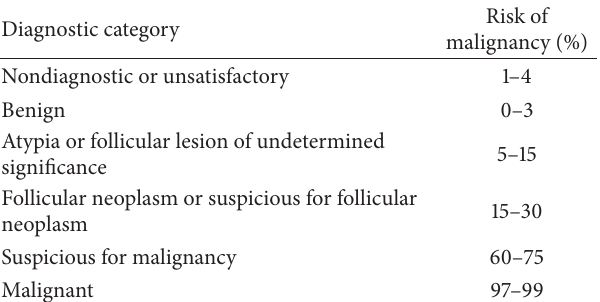
Table1:Fineneedleaspirationbiopsydiagnosticcategories,adapted from Cibas and Ali (The Bethesda System for Thyroid Cytopathol- ogy) [6].